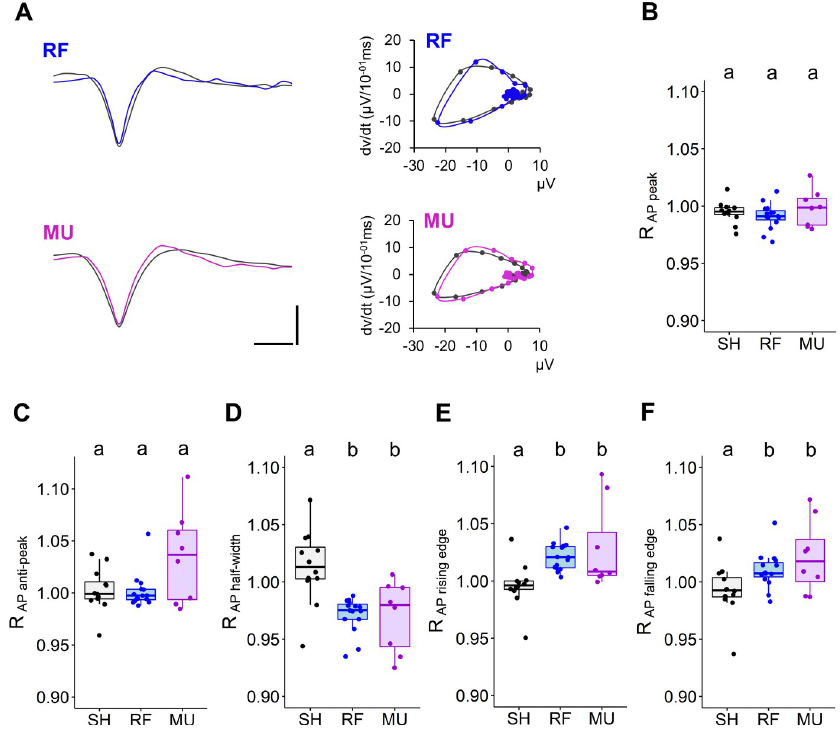
Fig 5. Change in AP waveform in response to RF and MU exposure. (A) Representative average AP traces from a single unit (left) and associated phase plot (right) before and during exposure to RF (top) and MU (bottom). Scale: (y): 15 μ V; (x): 500 μ s. (B-F) Boxplots showing variation in AP peak (B) and anti-peak amplitude (C) half-width (D) maximal rising (E) and falling edge (F). Normalized data, ratio of the exposure phase to baseline. SH, n = 12; RF, n = 15; MU, n = 8. (B-F). Lower case letters indicate significant differences between